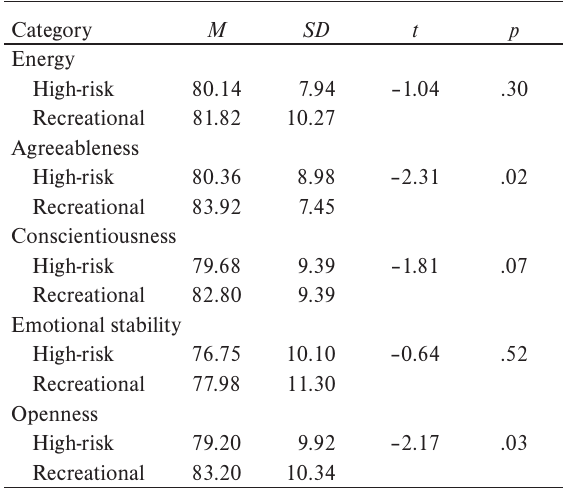
Differences between high-risk sports athletes and recre-